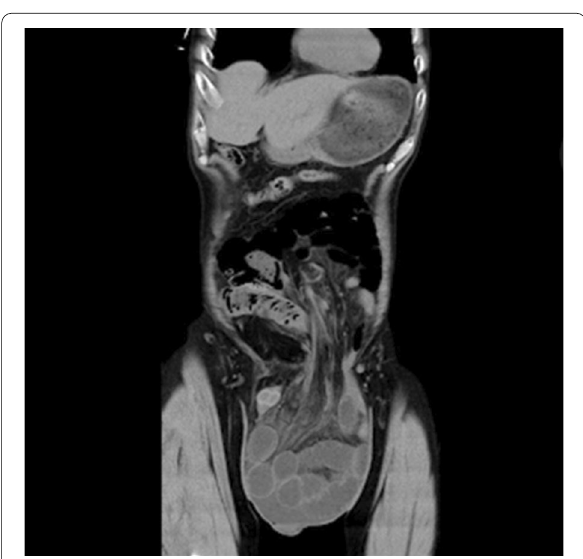
Fig. 1 Computed tomography finding of a giant inguinoscrotal hernia